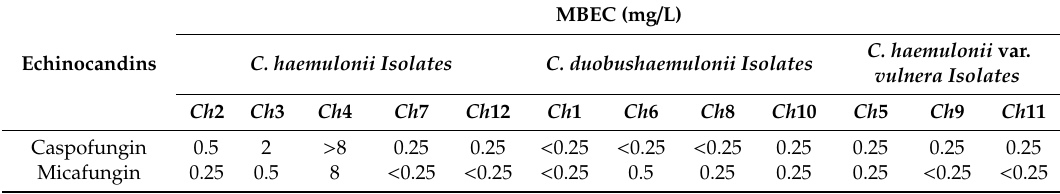
Table6. Minimalbiofilmeradicationconcentration(MBEC)toechinocandinsagainst C.haemulonii complex.